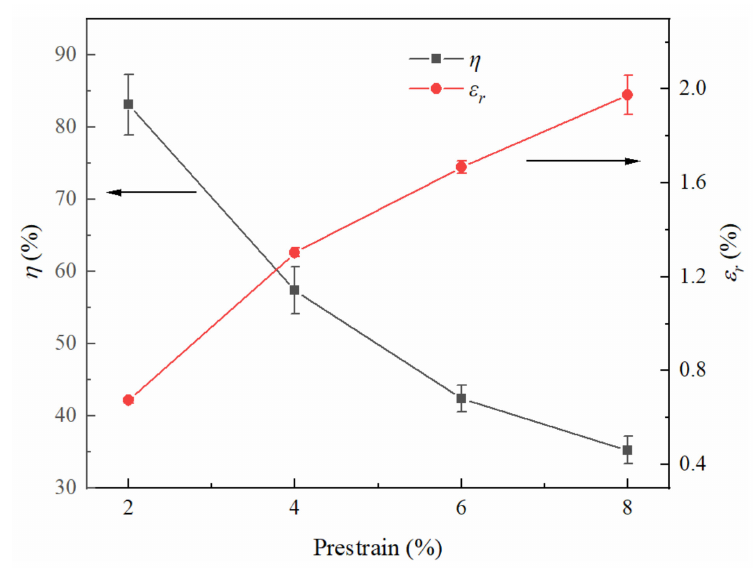
Figure 7. Shape memory effect of the solutionized specimens.